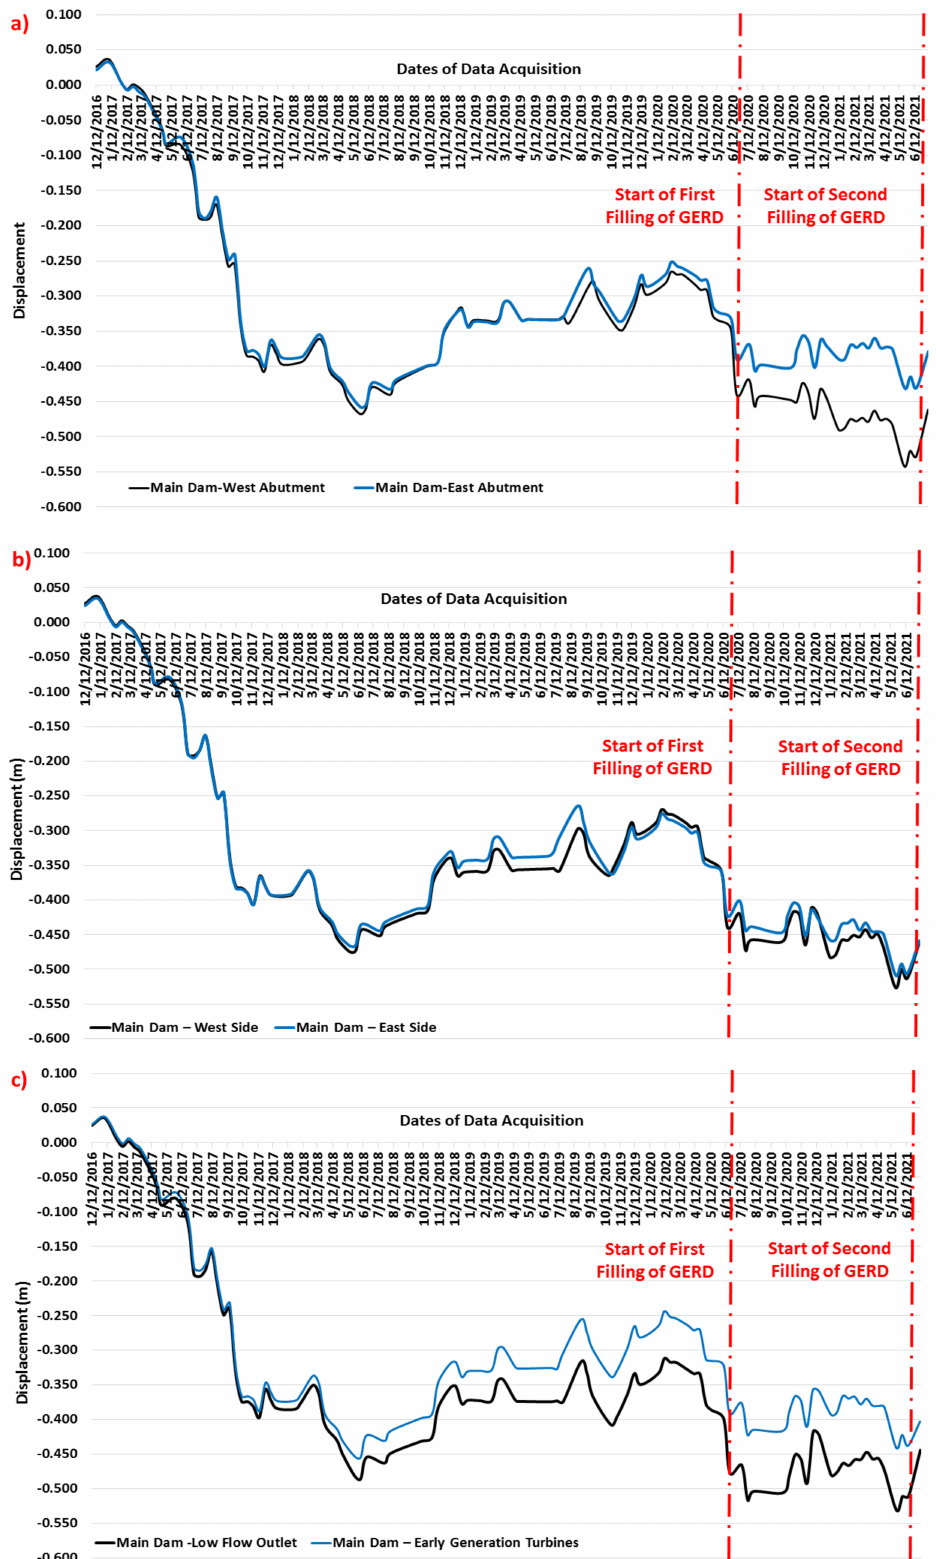
Figure 5. Observed vertical displacement over the GERD’s Main Dam at ( a ) east and west abutment, ( b ) west and east sides and ( c ) low flow outlet and early generation